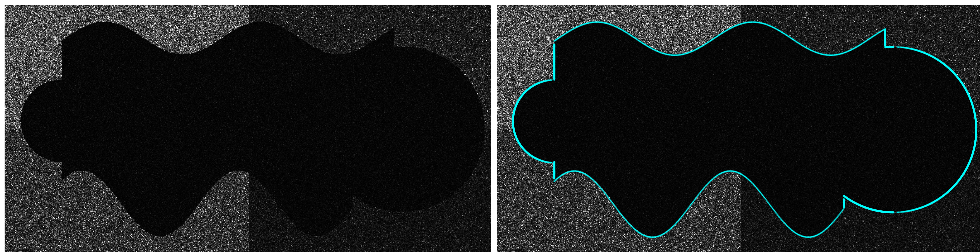
Figure 2. Synthetic image ( left ) with L = 2 and the actual border ( right